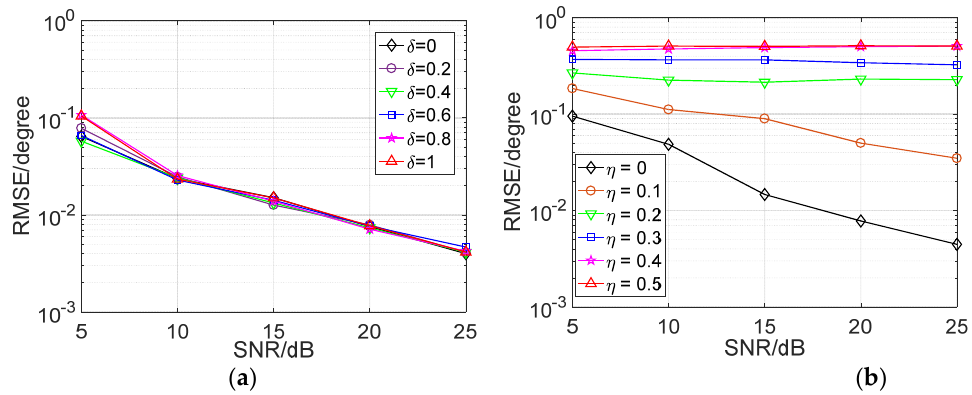
Figure 3. ( a ) Average RMSE vs. SNR with various gain error range δ , and ( b ) Average RMSE vs. SNR with various phase error range η .